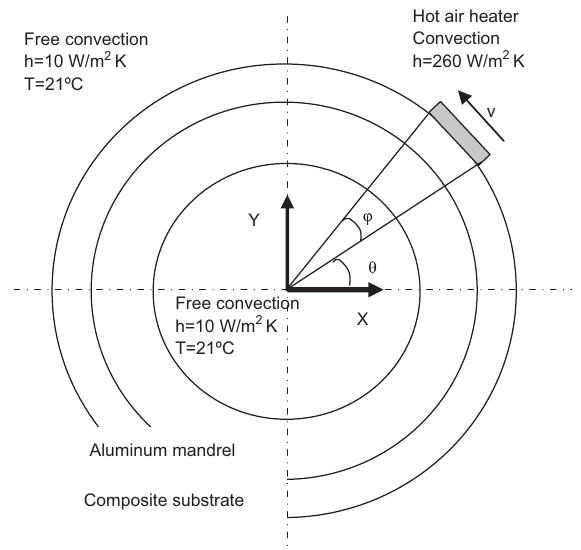
Figure 3 Model of the assembly and boundary